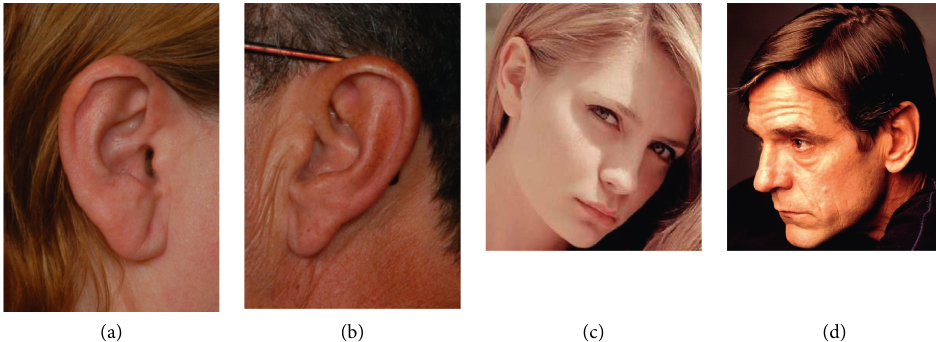
Figure 6: Examples of original ear images. (a) Example of a 2D profile image of a female. (b) Example of a 2D profile image of a male. (c) Example of a facial image of a female. (d) Example of a facial image of a male.